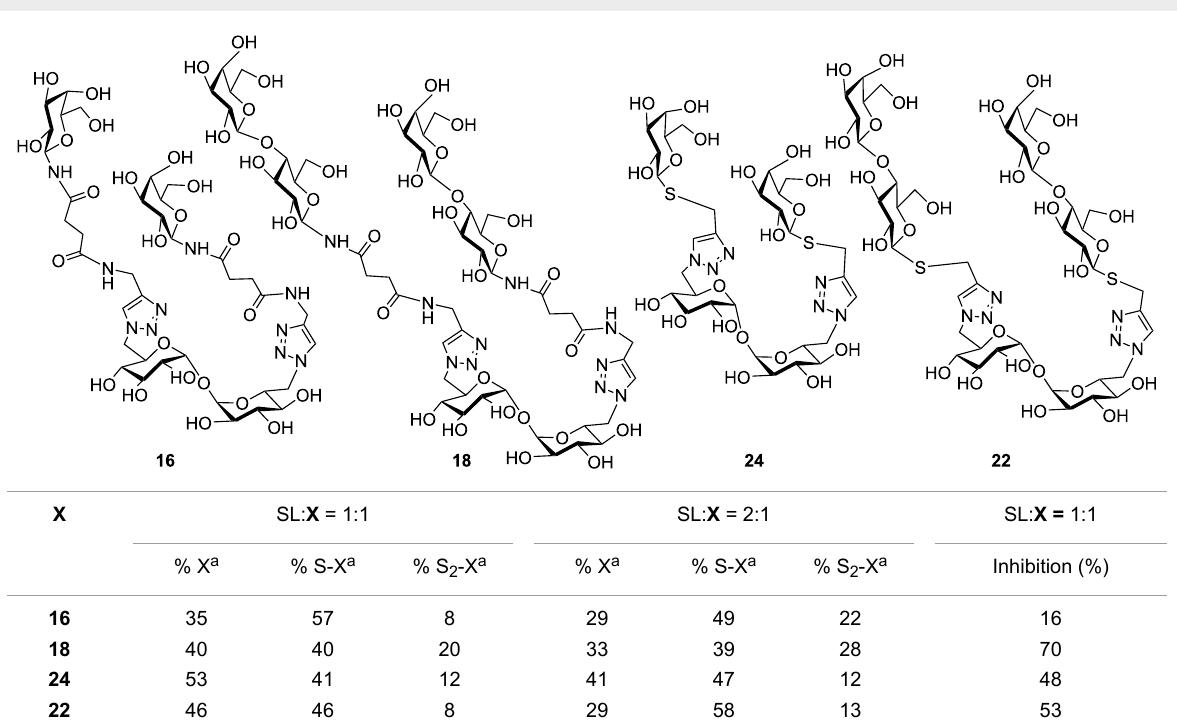
Table 2: Evaluation of the divalent substrates in the TcTS